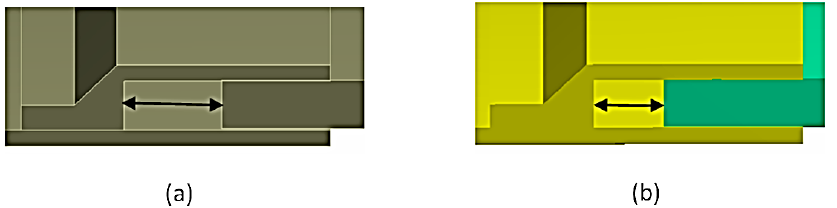
Figure 15. Coupling of the combustion chamber outer wall with the turbine stator: ( a ) Position at room temperature; ( b ) new position after thermal expansion.